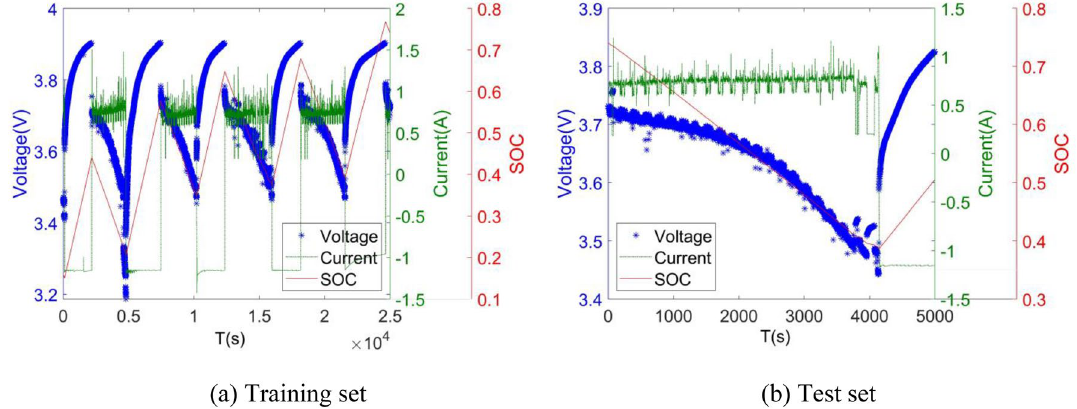
Figure 12 Experimental data for training and test